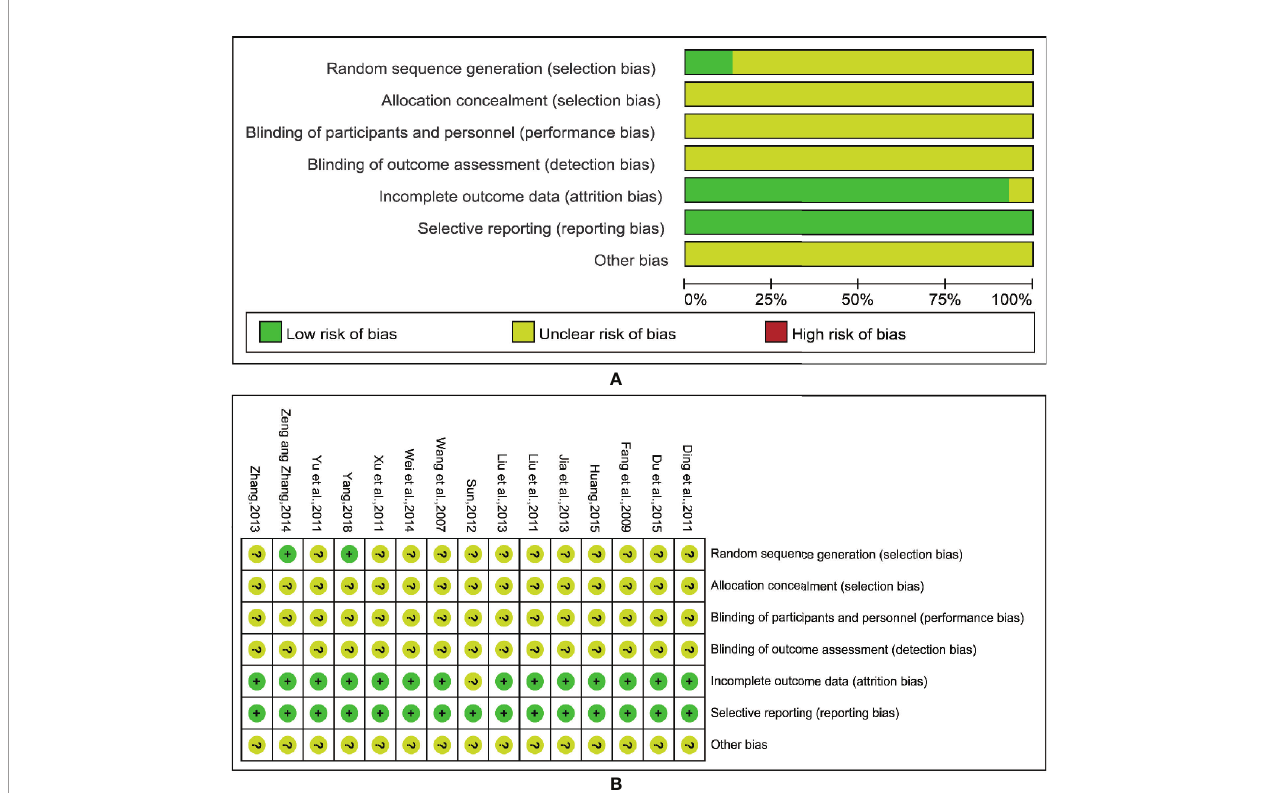
FIGURE 2 | Risk of methodological bias of the included studies. (A) Risk of bias graph. (B) Risk of bias summary.